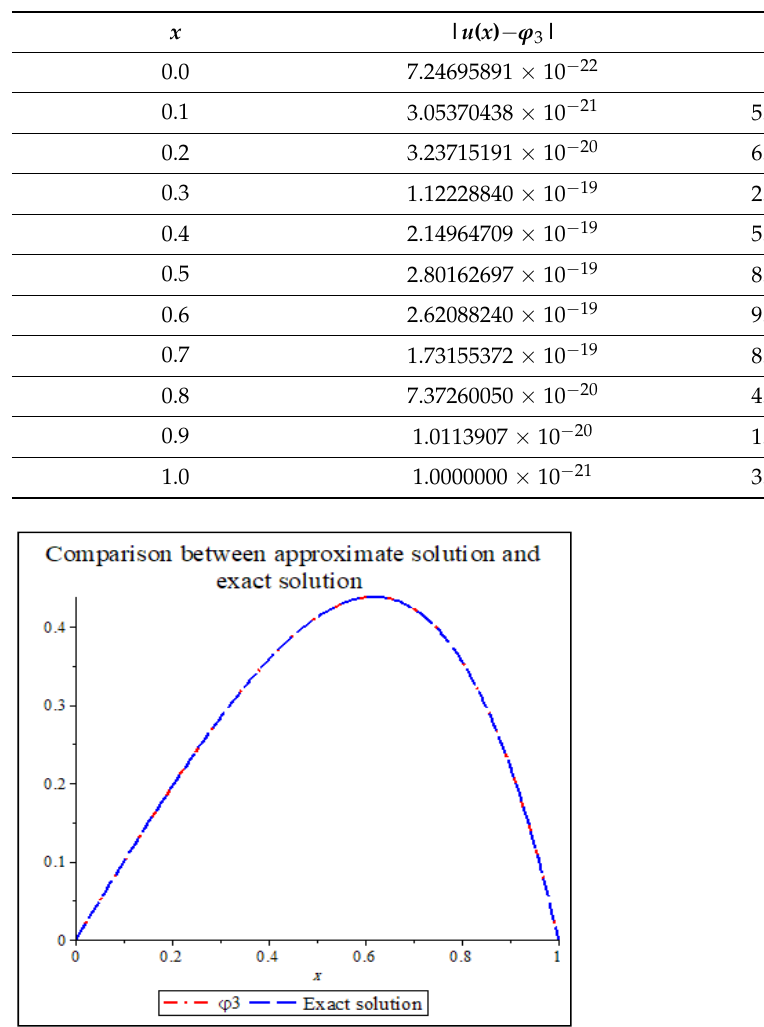
Table 4. The absolute error between the exact solution and the approximate of ϕ 3 in Example 4.